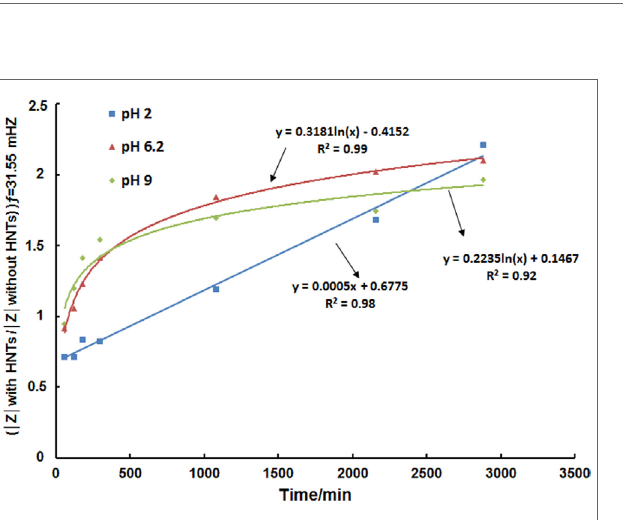
FigUre 6 | impedance diagrams: nyquist plots for carbon steel after different immersion times in 0.1 mol/l nacl at ph 2, 6.2, and 9 and containing 1 wt.% of halloysite nanotubes without encapsulated dodecylamine .